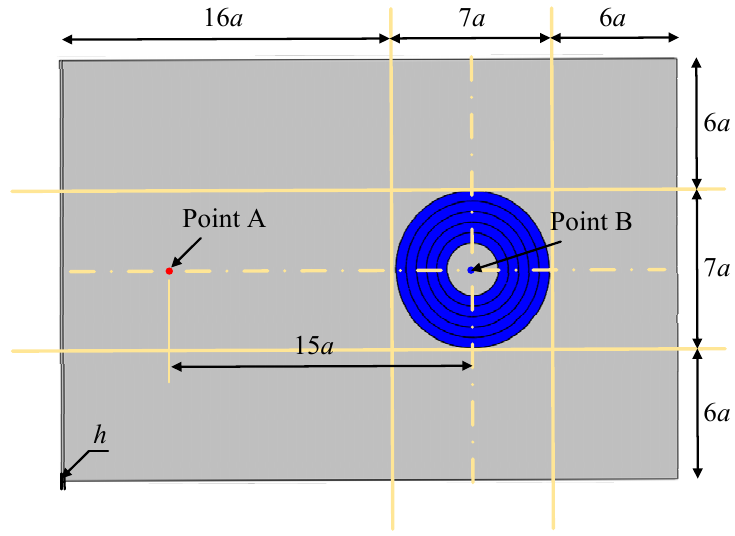
Figure 11. Three-dimensional full-scale finite periodic REM structure.